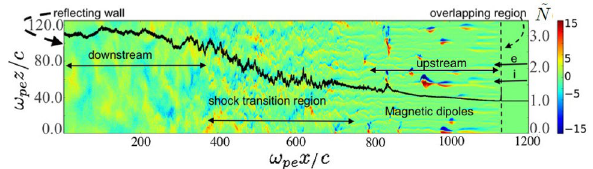
Figure 1. Schematic of the interaction of two interpenetrating electron/ion beams: Color plot of normalized 1140 . Solid black line (axis on right): transversely z plane at ω pe t out of plane magnetic field ( B y ) in x = − averaged density ˜ N normalized to upstream unperturbed density n 0 . The dashed line is where the incoming e/i beams meet the counter streams.